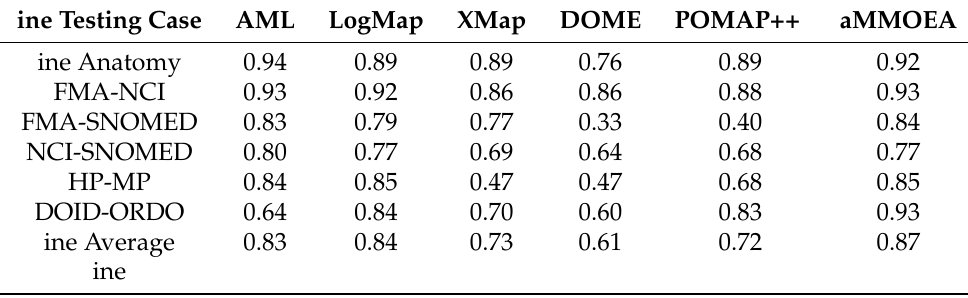
Table 6. Comparison with OAEI participants in terms of